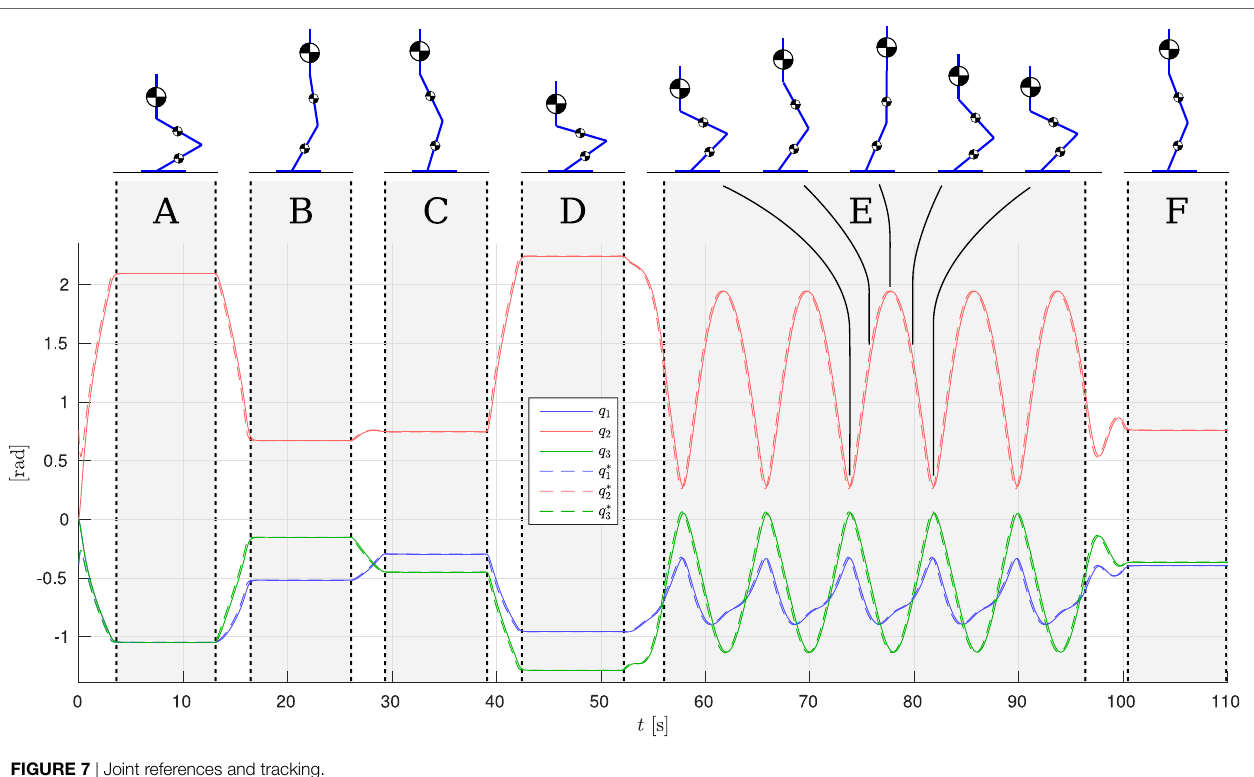
FIGURE 7 | Joint references and